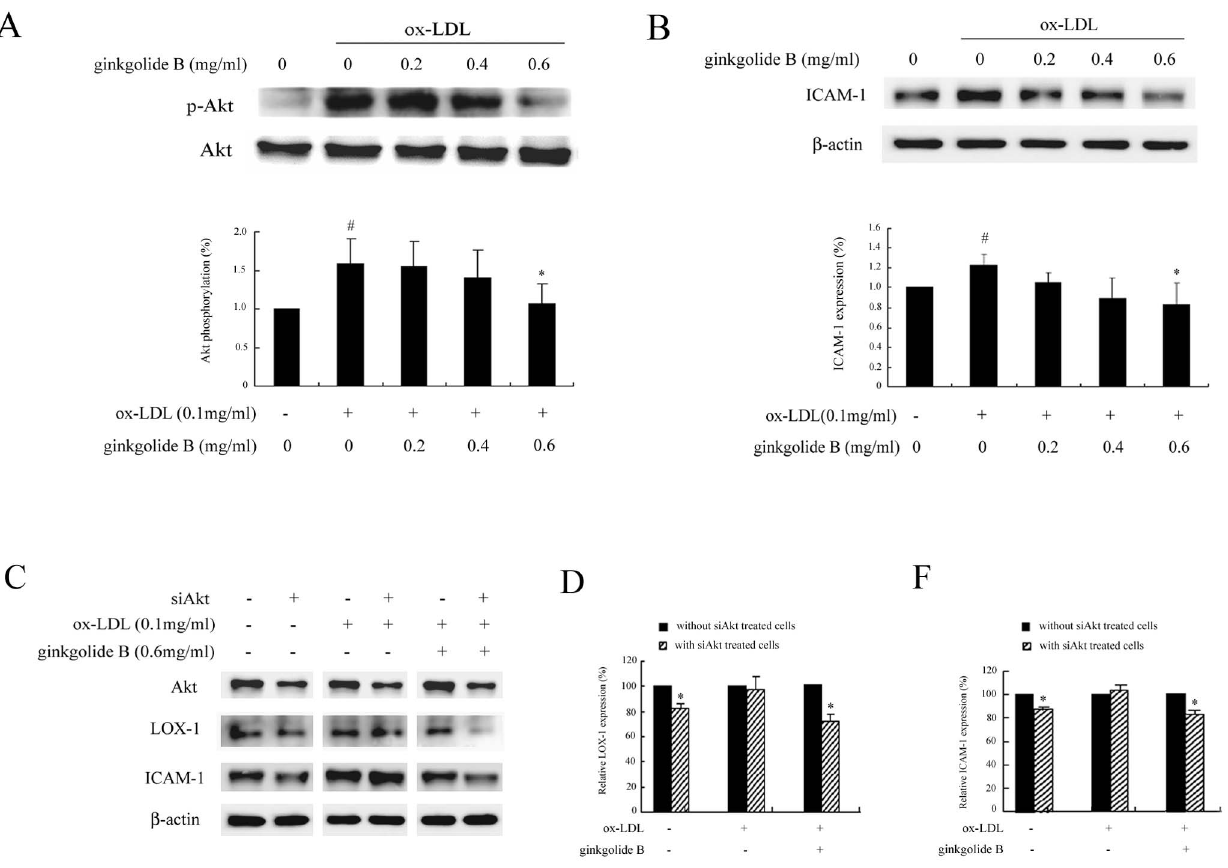
Figure 3. Ginkgolide B inhibits Akt phosphorylation and ICAM-1 expression in ox-LDL-stimulated endothelial cells. (A) Ginkgolide B inhibited Akt phosphorylation. # p , 0.05, compared with control; * p , 0.05, compared with ox-LDL-stimulated cells. (B) Ginkgolide B suppressed ICAM- 1 expression. # p , 0.05, compared with control; * p , 0.05, compared with ox-LDL-stimulated cells. (C) LOX-1 and ICAM-1 expression in Akt1 siRNA - transfected and -nontransfected cells. (D) Analysis of LOX-1 expression with Akt siRNA transfection. The results were obtained from three independent experiments. * p , 0.05, difference between Akt siRNA-transfected and -nontransfected cells. (F) Analysis of ICAM-1 expression with Akt siRNA transfection. * p , 0.05, difference between Akt siRNA-transfected and -nontransfected